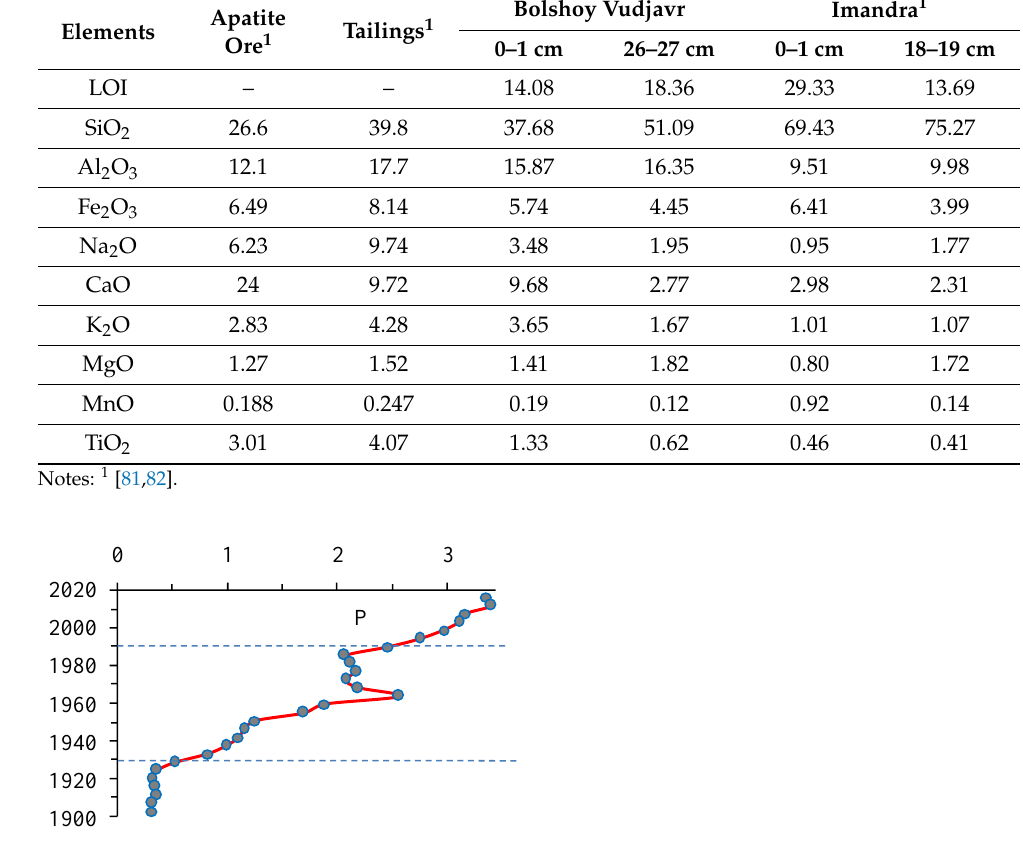
Figure 5. Vertical distribution of phosphorus content (%) in the sediments of Lake Bolshoy Vudjavr.